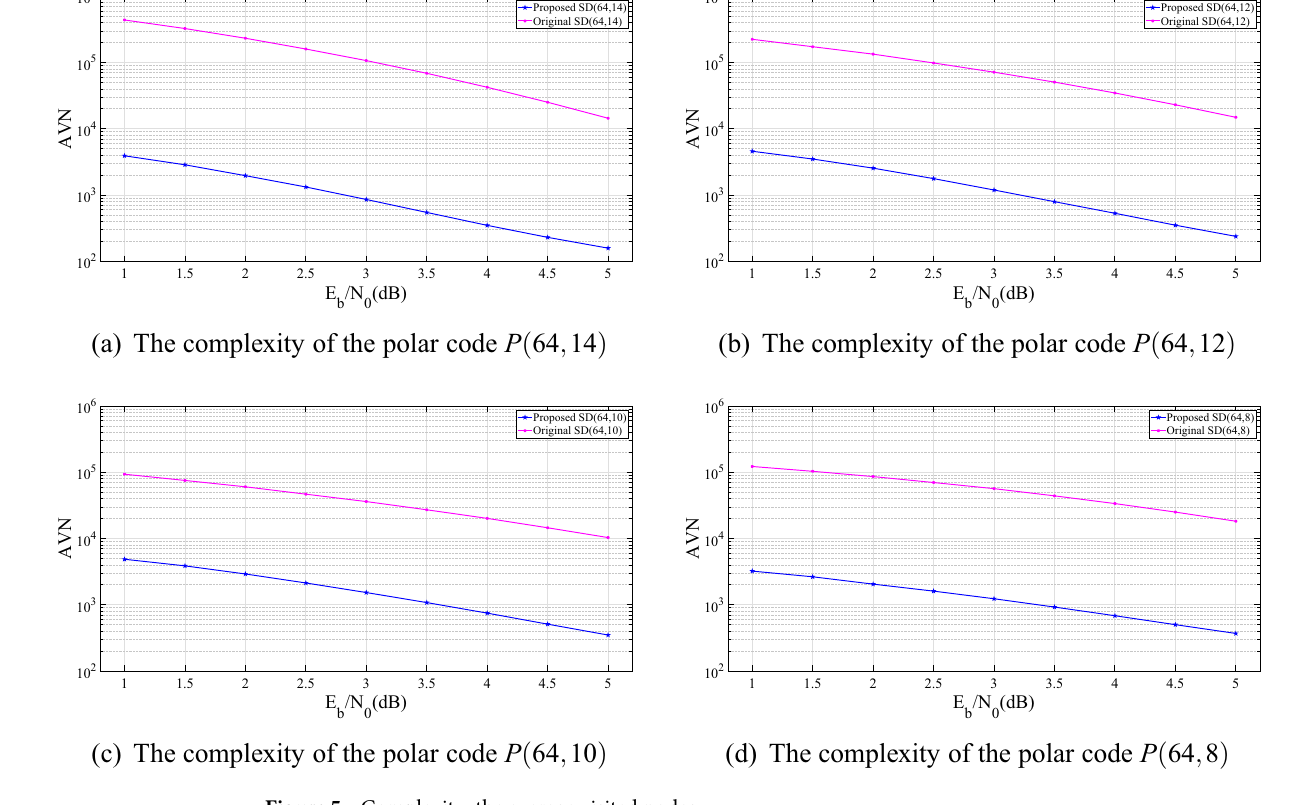
Figure 5. Complexity: the average visited